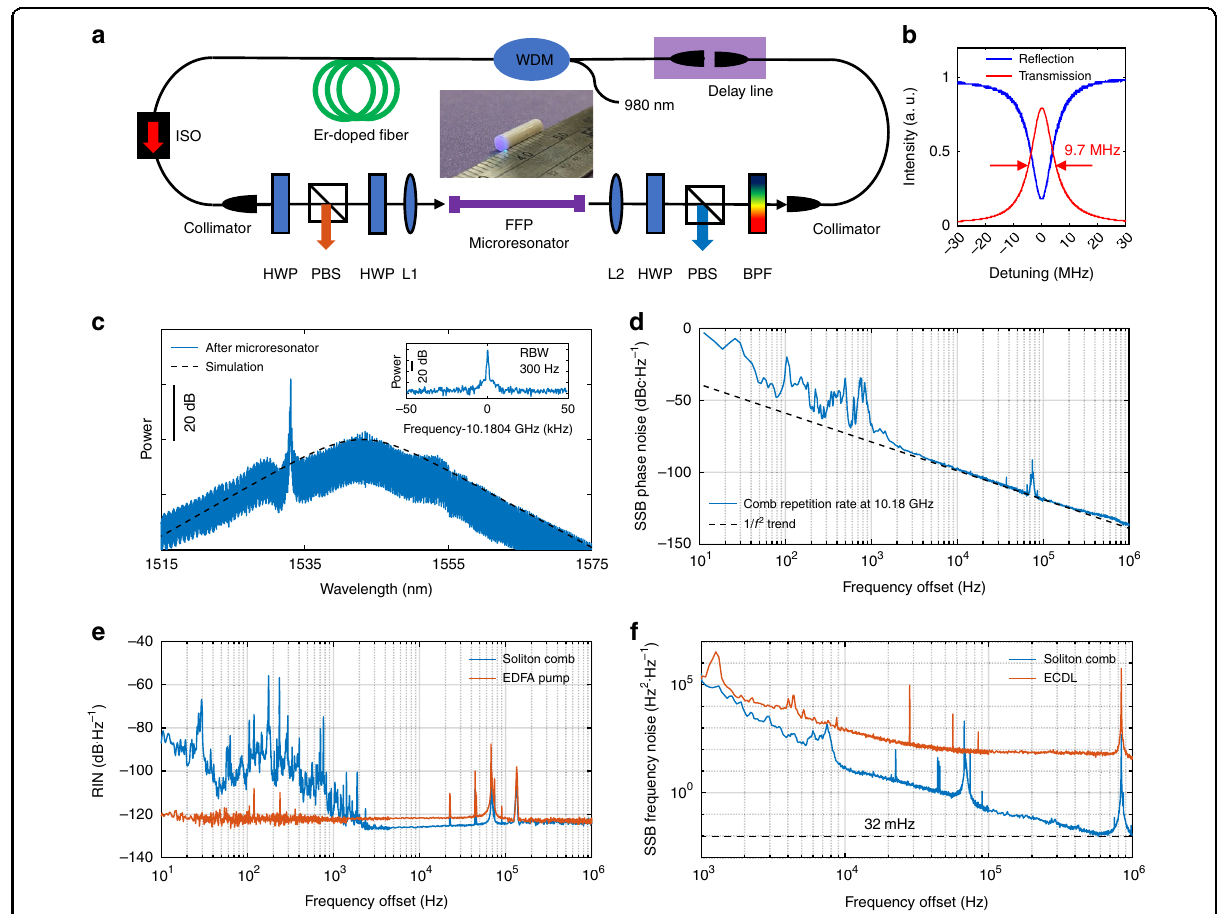
Fig. 2 Experimental generation of dissipative soliton. a Schematic of experimental setup. ISO: isolator, WDM: wavelength division multiplexer, HWP: half-wave plate, PBS: polarizing beam splitter, L1 and L2: lens, BPF: band-pass fi lter. b Transmission and re fl ection of the FFP microresonator. c Spectrum of the single soliton. Inset: RF beat note of the soliton repetition rate. d SSB phase noise spectrum of the single soliton. e RIN of the single soliton and the EDFA pump. f SSB frequency noise spectra of a comb line and a conventional ECDL (Toptica,